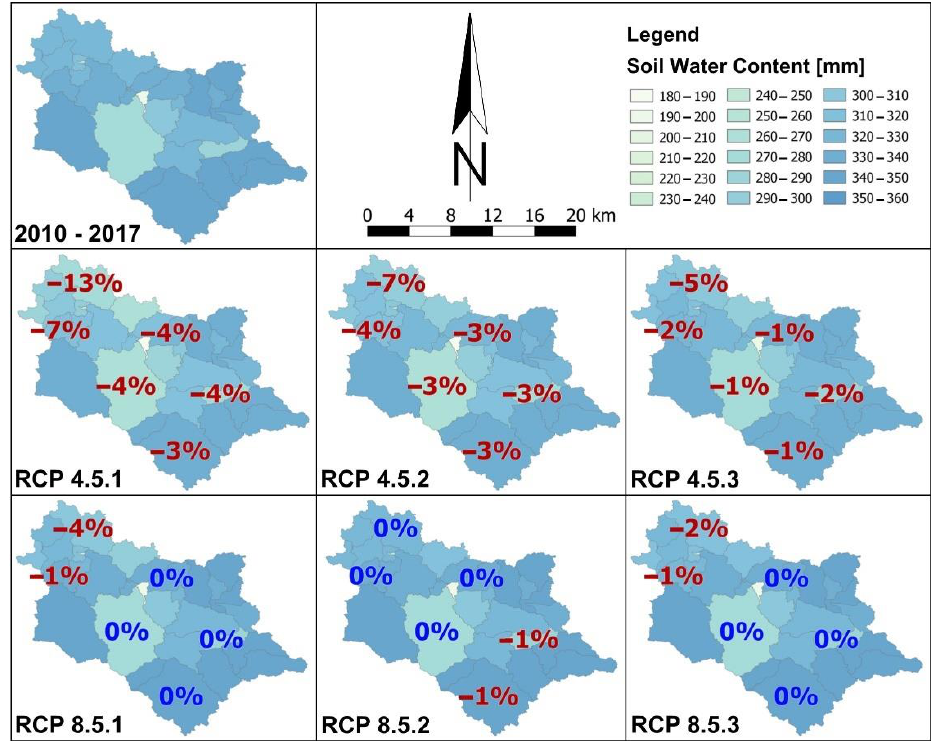
Figure 3. Comparison of average soil water content in 31 sub-catchments during the SWAT simulation period 2010 – 2017 and 2041 – 2050 for individual climate projections RCP 4.5.1, RCP 4.5.2, RCP 4.5.3, RCP 8.5.1, RCP 8.5.2, RCP 8.5.3 (own study).